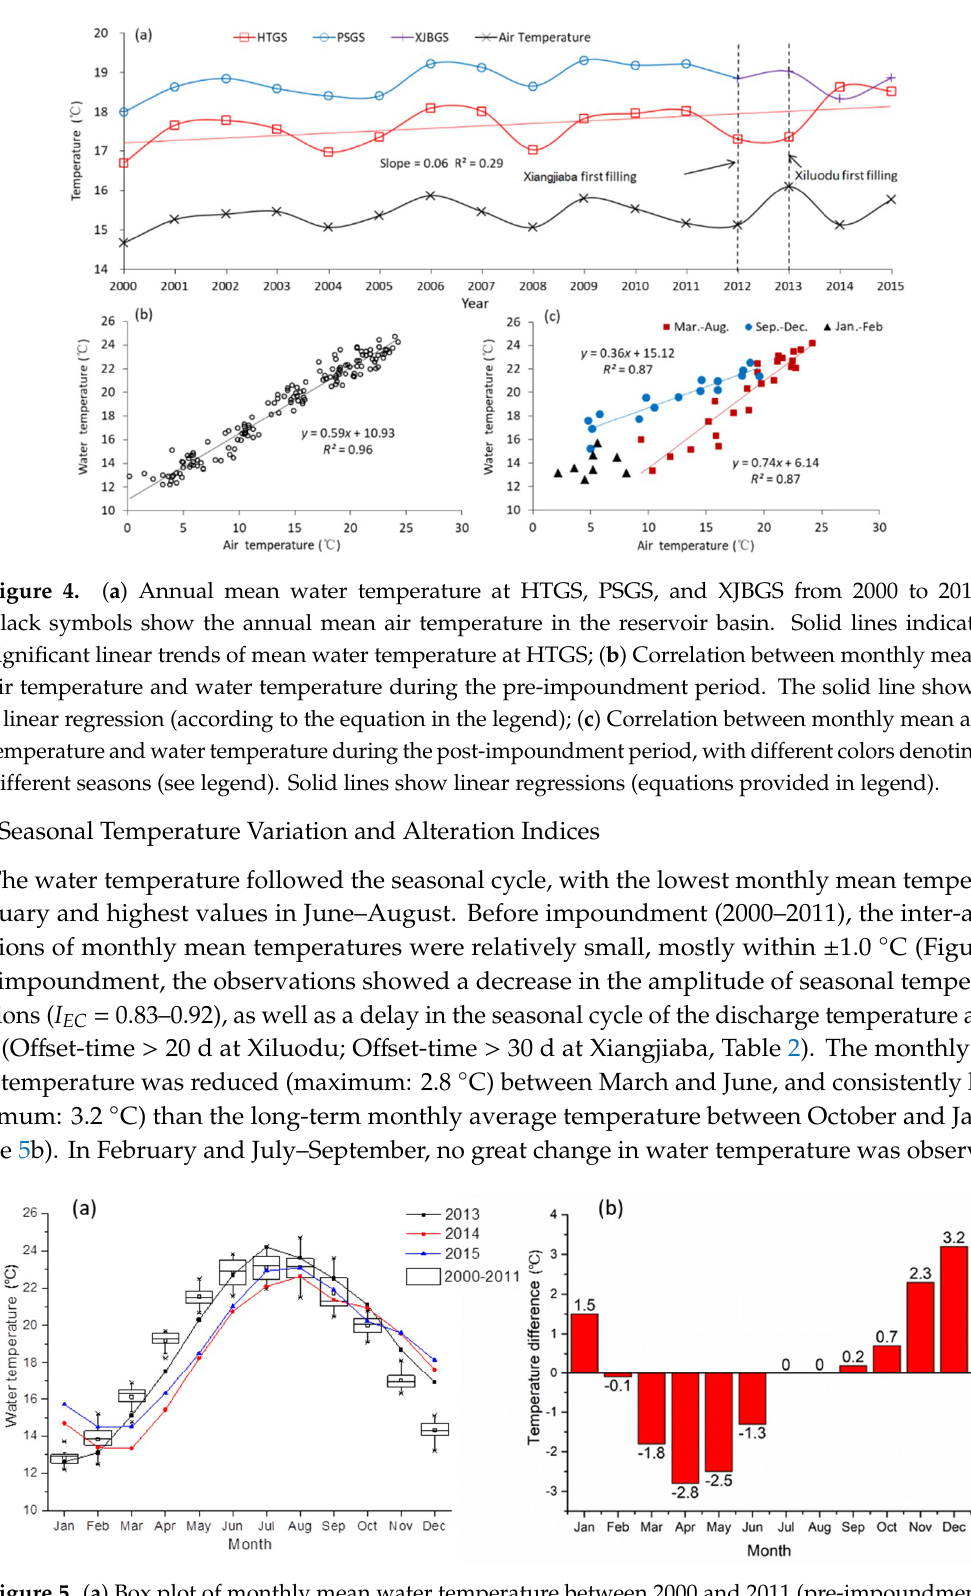
Figure 5. ( a ) Box plot of monthly mean water temperature between 2000 and 2011 (pre-impoundment period) at PSGS (see caption of Figure 3 for explanations of the box plot elements). The line plot shows the measured water temperature at XJBGS in 2013–2015 (post-impoundment). ( b ) Monthly mean temperature difference between the post- and pre-impoundment periods at XJBGS (monthly average temperature in 2013–2015 minus monthly average temperature from 2000 to 2011). Table 2. Baseline deviation index ( I BD , Equation (1)), phase offset time index ( I PO , Equation (2)), extreme fluctuation index ( I EC , Equation (3)). We considered the monthly average water temperature at PSGS from 2000–2011 as the natural water temperature baseline (pre-impoundment period).